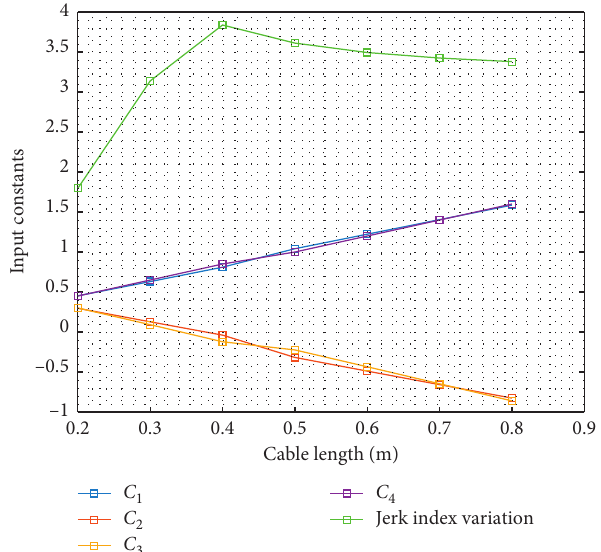
Figure 9: Input constants and jerk index variation versus cable length for the standard maneuver time.